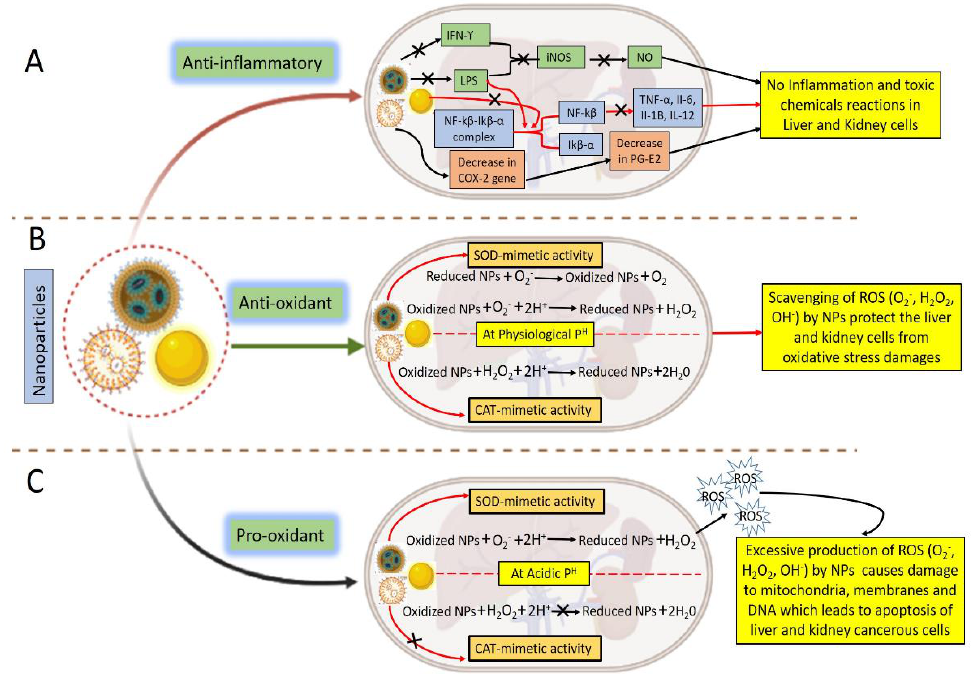
Figure 3. Possible mechanism adopted by NPs to ameliorate the hepato-renal toxicity: ( A ) Anti- inflammatory; ( B ) antioxidant; and ( C ) pro-oxidant.